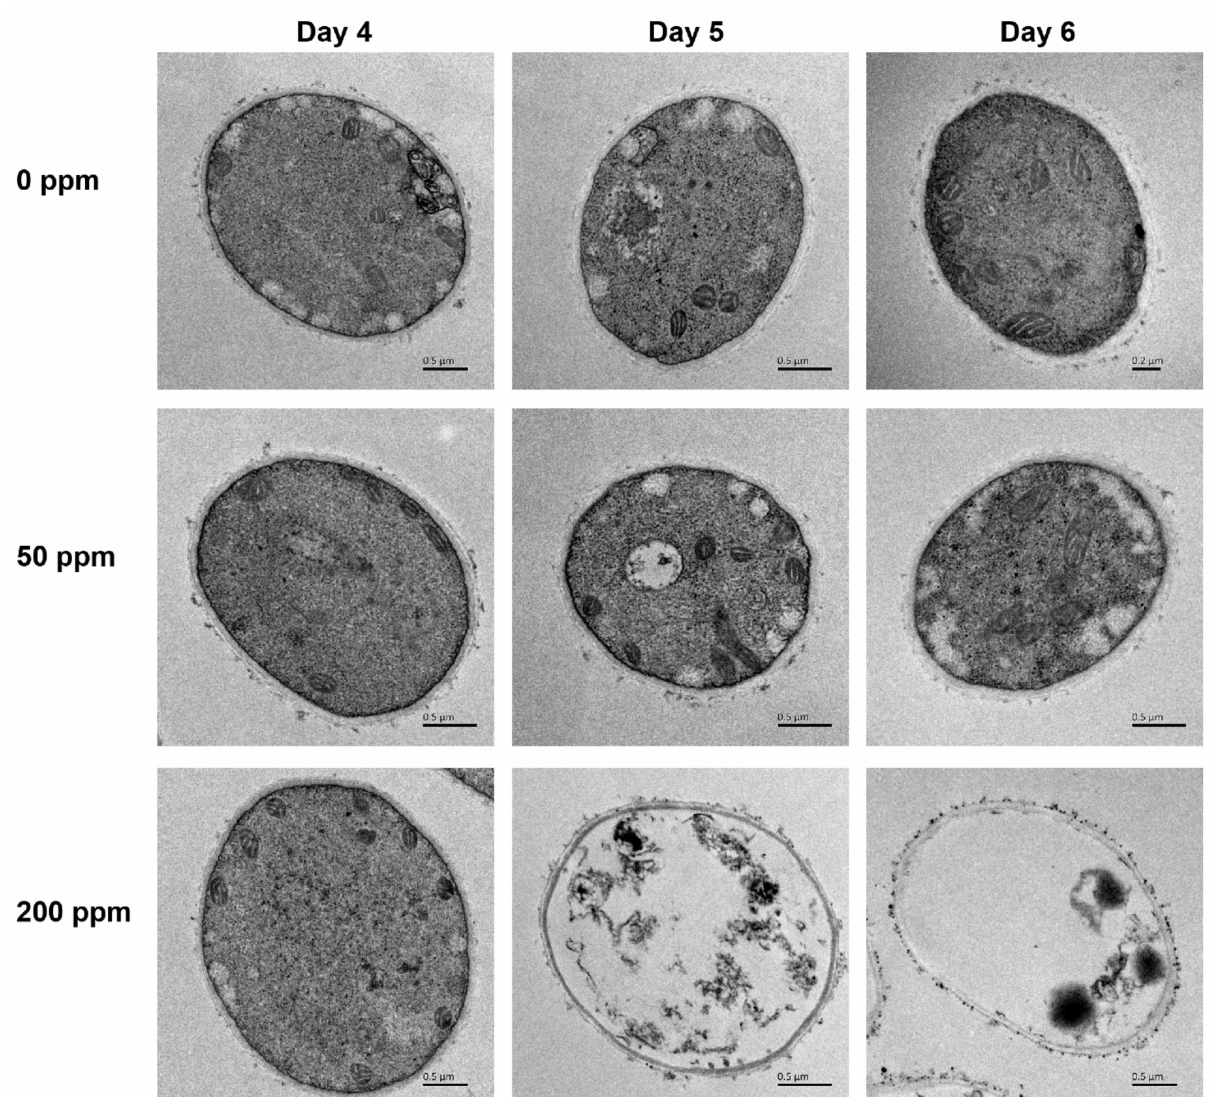
Figure 2. Ultra-structure of Ganoderma lucidum mycelia with selenite supplementation at different concentrations. 3.3. Changes in Mycelial Cell Chemical Composition Quantitative analysis of intracellular nucleic acid and protein, cell wall components (chitin and β -1,3-glucan), and a cell membrane component (ergosterol) were performed to detect the cell structure and physiological state caused by Se supplementation (Figure